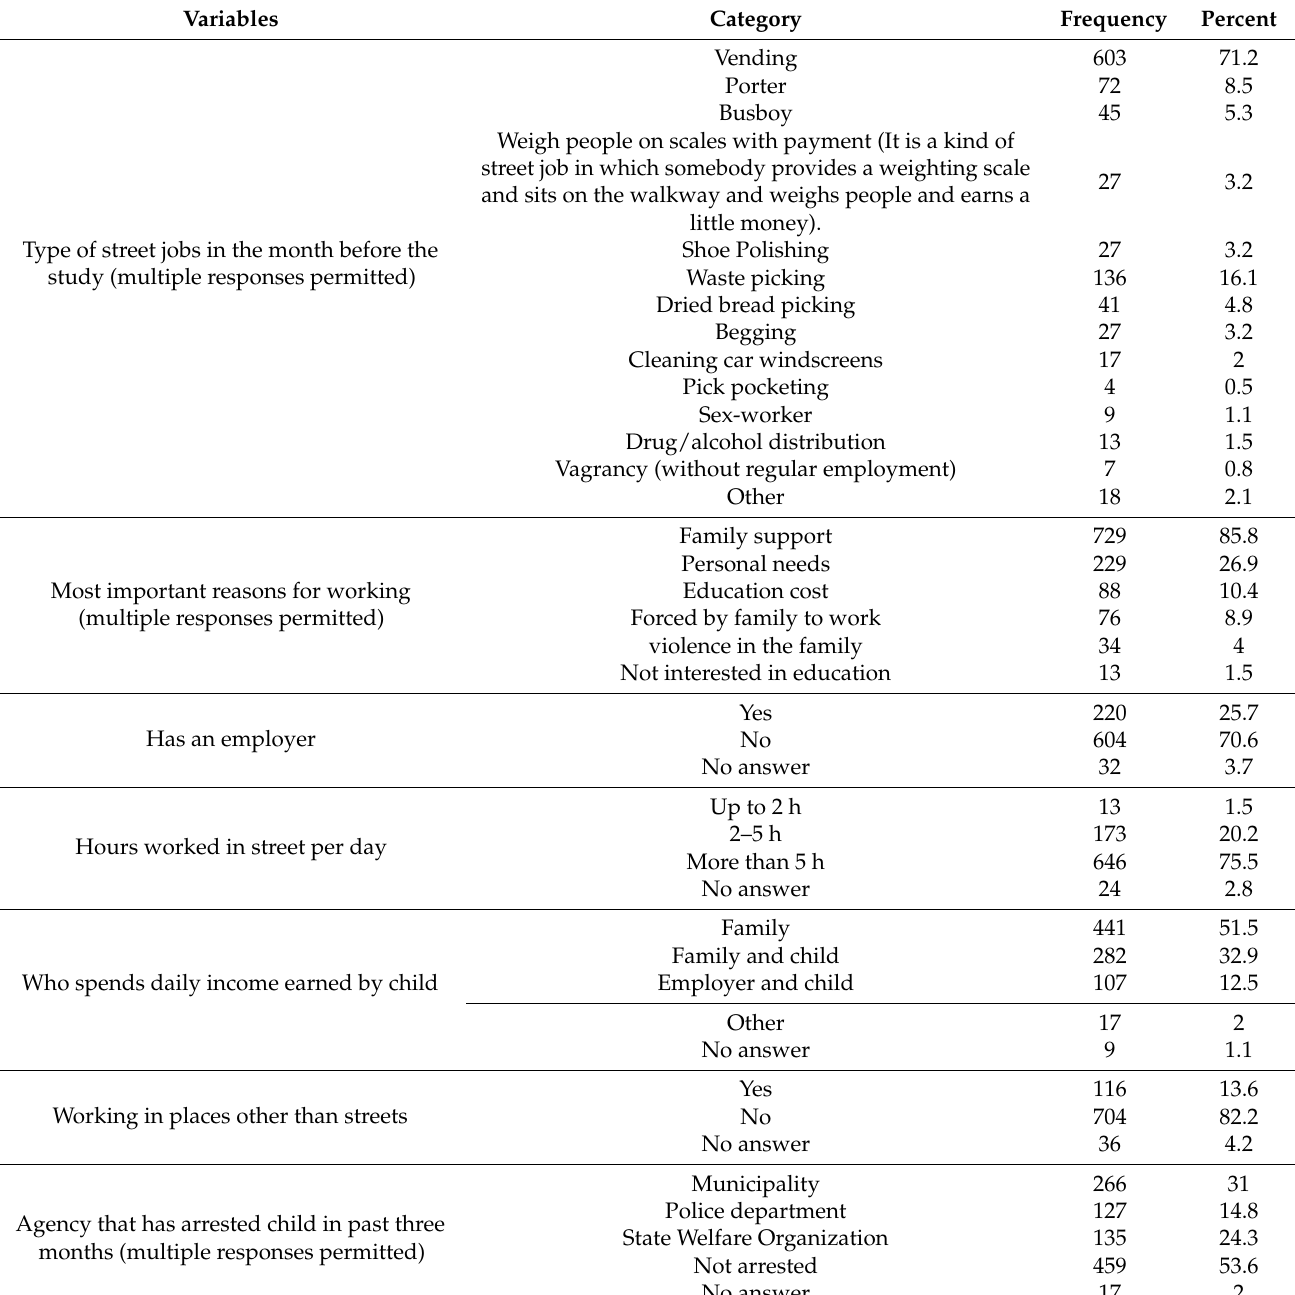
Table 2. Working conditions of street children in six provinces of Iran ( n = 856). Variables